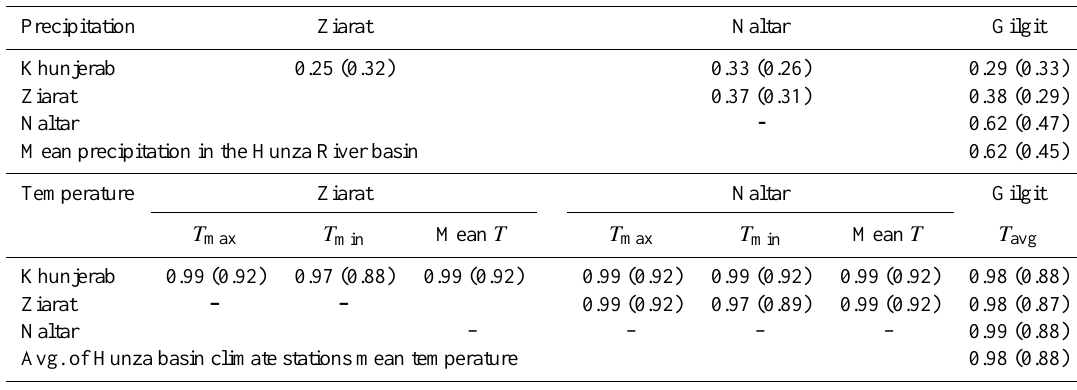
Table 3. Monthly climate data (precipitation and temperature) correlation coefficients between three climate stations of the Hunza River basin (1999–2007) and Gilgit climate station (1999–2007). Precipitation Ziarat Naltar Gilgit Khunjerab 0.25 (0.32) 0.33 (0.26) 0.29 (0.33) Ziarat 0.37 (0.31) 0.38 (0.29) Naltar - 0.62 (0.47) Mean precipitation in the Hunza River basin 0.62 (0.45) Temperature Ziarat Naltar Gilgit T max T min Mean T T max T min Mean T T avg Khunjerab 0.99 (0.92) 0.97 (0.88) 0.99 (0.92) 0.99 (0.92) 0.99 (0.92) 0.98 (0.88) Ziarat – – 0.99 (0.92) 0.97 (0.89) 0.99 (0.92) 0.98 (0.87) Naltar – – – – 0.99 (0.88) Avg. of Hunza basin climate stations mean temperature 0.98